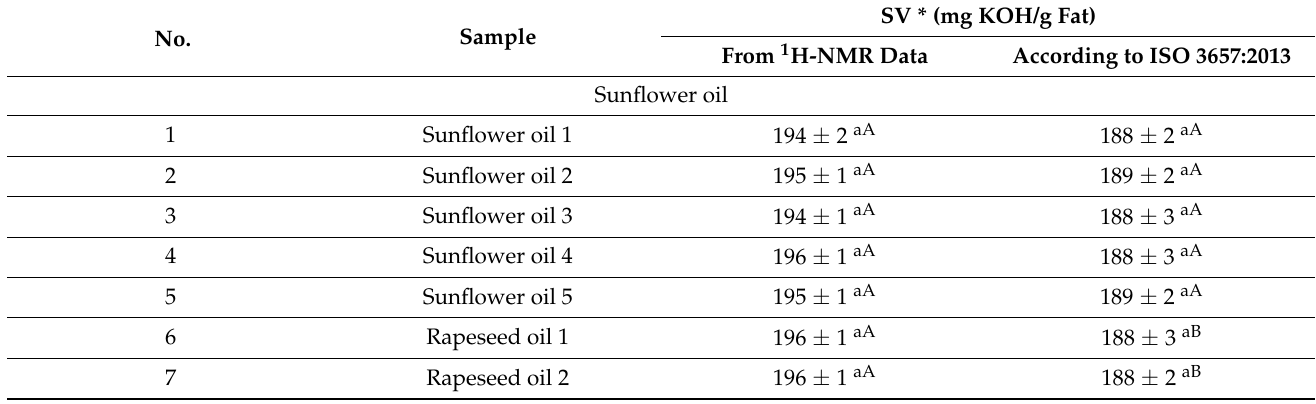
Table 3. SVs determined from 1 H-NMR data and through the standard (ISO 3657:2013) method for a series of edible fats and oils (95% confidence level).